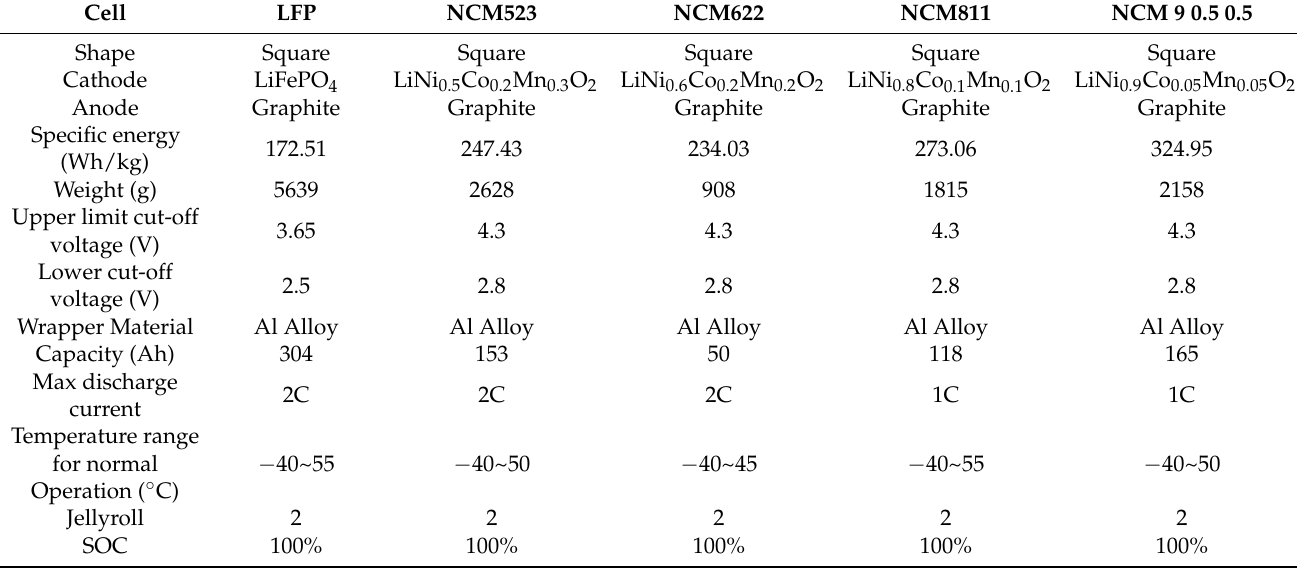
Table 2. Battery information used in this